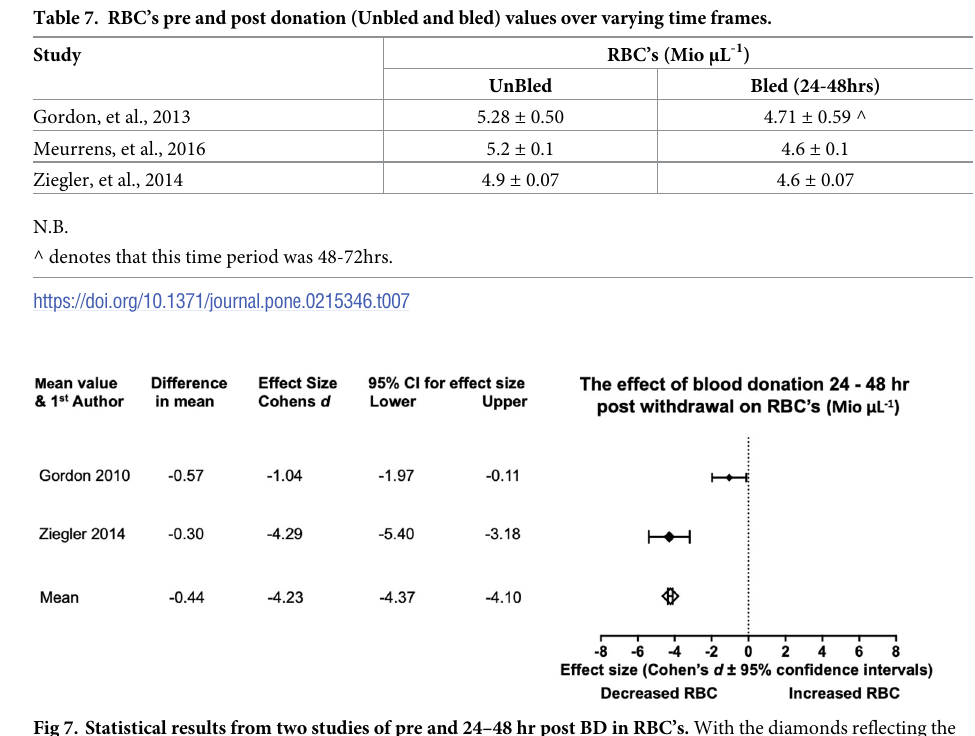
Fig 7. Statistical results from two studies of pre and 24–48 hr post BD in RBC’s. With the diamonds reflecting the effect size of the studies. The white diamond shows the overall mean effect size. All effect sizes are Cohen’s d and 95% confidence interval, with heterogeneity of I 2 =